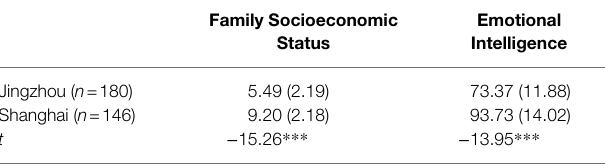
TABLE 1 | Comparison of differences in family socioeconomic status and emotional intelligence of primary school students in different regions M